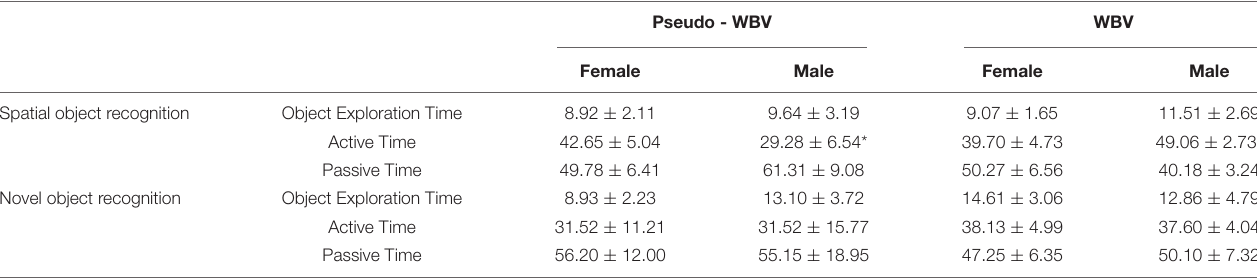
TABLE 1 | Effects of whole body vibration on object exploration time (time spent at both familiar object and novel/replaced object), on active time (i.e., unprompted motor activity such as walking or rearing), and on passive time (i.e., sitting and lying and time spent with grooming) during the spatial and novel object recognition tests.